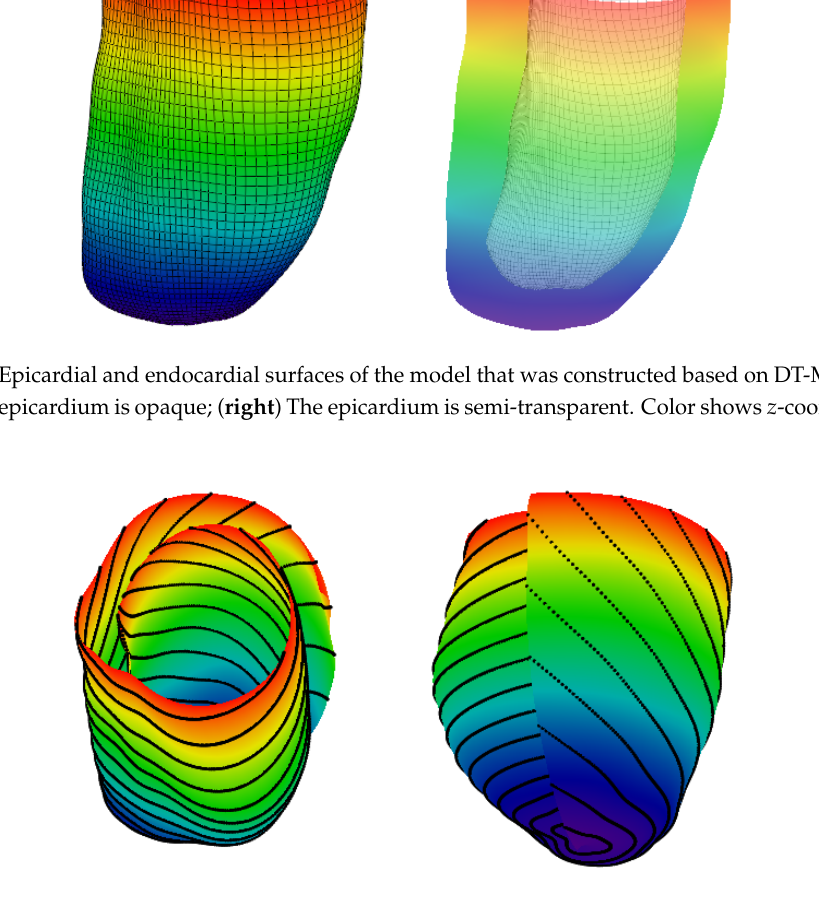
Figure 5. A spiral surface (SS) with fibers on it. Two views are shown. The left of the figure depicts a view from the top and side of the SS, while the right of the image provides a side view with the mid-myocardial part on the left and the epicardial layer on the right. Color shows z